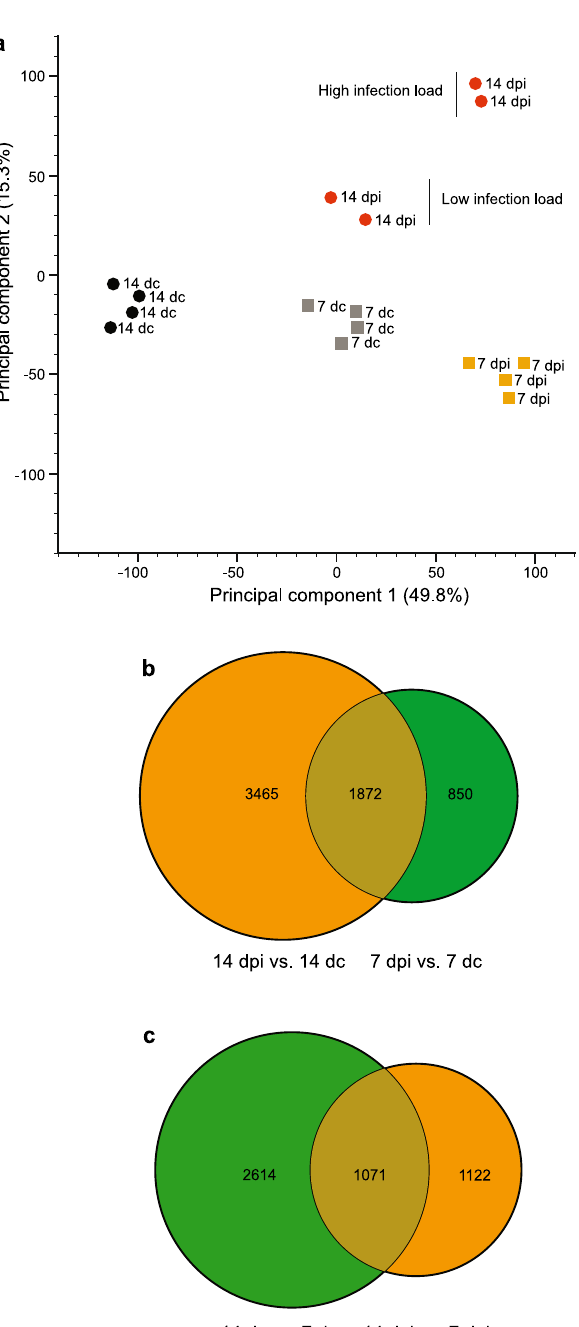
Figure 2. Plasmodium falciparum infection stage affects antennal transcript abundance in Anopheles gambiae . Principal component analysis ( a ) of the overall transcript abundance in the antennae of midgut oocyst- infected (7 days post-infection, dpi) and salivary gland sporozoite-infectious (14 dpi) mosquitoes compared to age-matched uninfected mosquitoes (7 days control, dc and 14 dc). Plasmodium falciparum infection load is indicated (see Supplementary Fig. 1). Proportional Venn diagrams ( b , c ) depicting pairwise comparisons among the antennal transcriptomes of midgut oocyst-infected, salivary gland sporozoite-infectious, and age-matched uninfected females. Overlapping regions represent the subsets of transcripts that are shared between the different conditions. Significant differences in transcript abundance were determined as a fold change of greater than 1.5, and an FDR-corrected p -value <